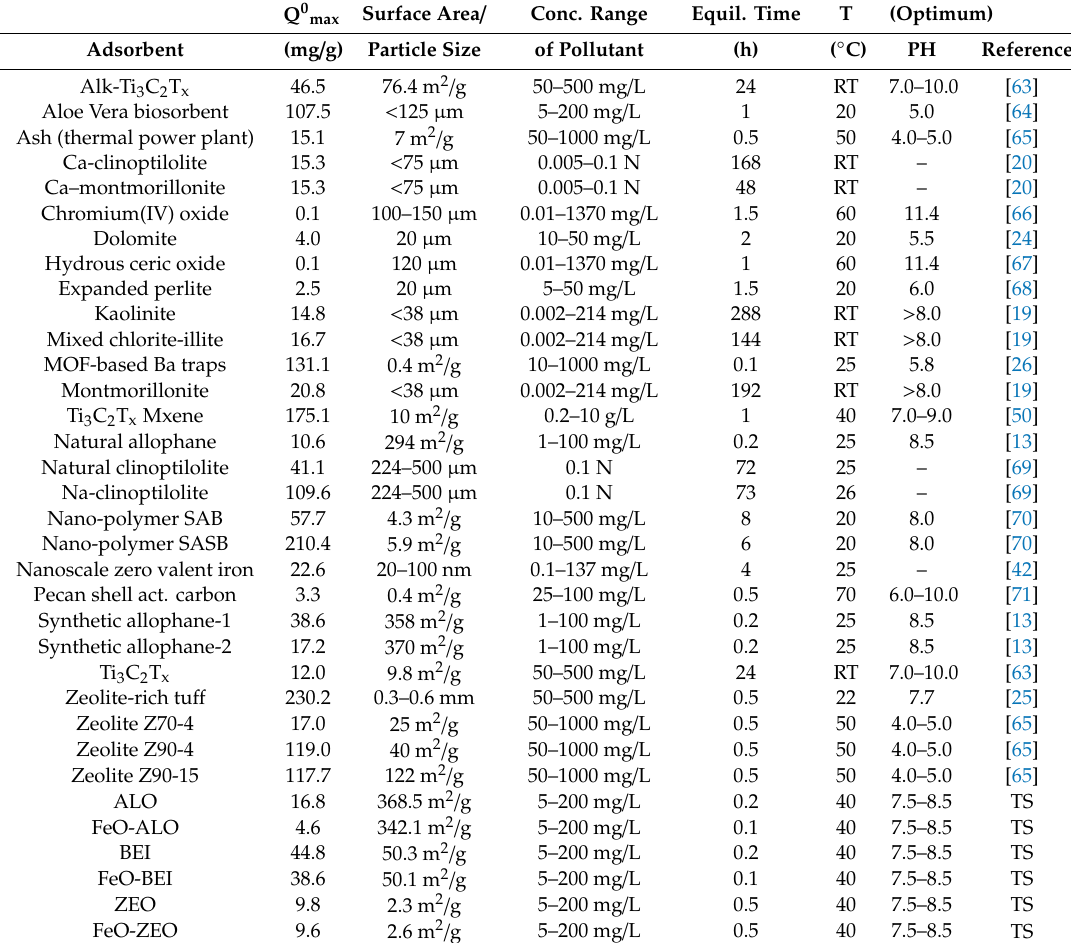
Table 7. Comparison of the adsorption capacities of various materials for the adsorption of Ba 2 + from solution under di ff erent operational conditions. TS—this